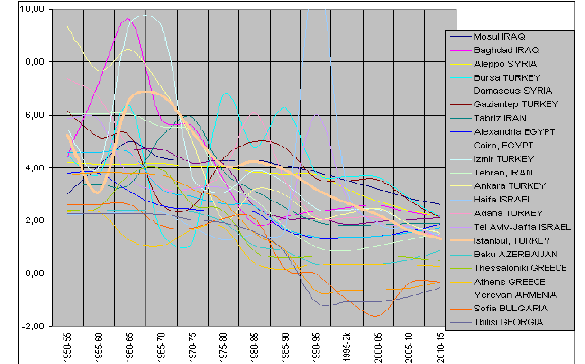
Figure 16: Annual growth-rates of the neighboured agglomerations, based on Data of the World Urbanisation Prospects - Revision